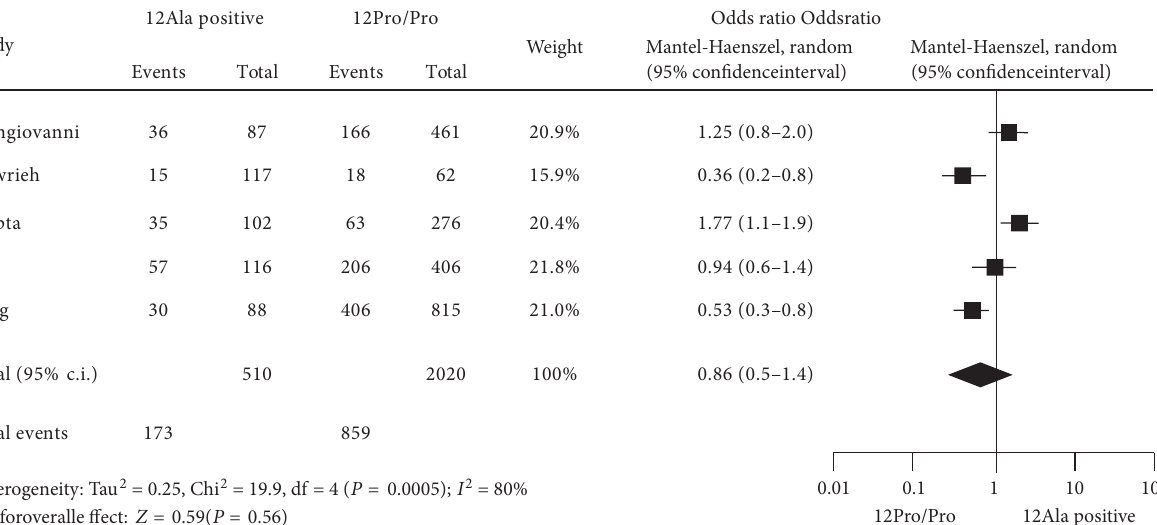
Figure 1: Meta-analysis of the effect of the Pro12Ala PPAR 𝛾 variant on the risk of NAFLD in published studies. The odds ratio (ORs) and the corresponding 95% confidence interval (c.i.) limits (lower and upper) are calculated by random effects meta-analysis (Mantel-Haenszel; M- H) for nonalcoholic fatty liver disease (NAFLD) according to the Pro12Ala variant (12Ala positive versus 12Pro/Pro genotype). In the “Study” is cited the first author of the study. “Events” indicate the number of patients with NAFLD who carry a genotype (e.g., 36 positive for 12Ala allele) while “Total” indicates the sum of patients and controls with the same genotype (e.g., 87 is the sum of NAFLD patients and controls who carry the 12 allele). In the graph, numbers indicate OR and filled diamond express random effect. The symbol size is proportional to the weight of the